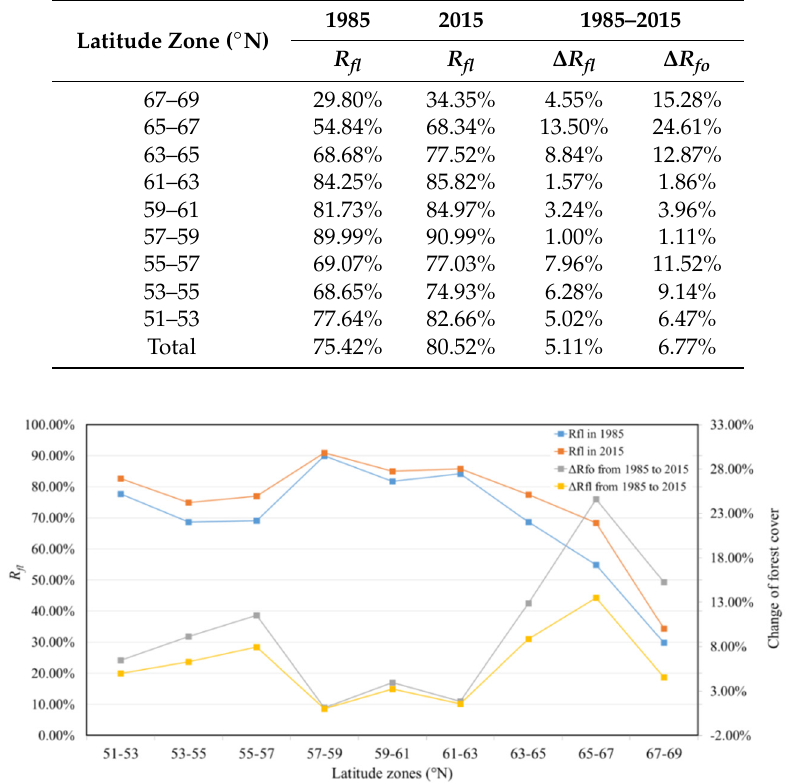
Table 3. Forest land area and ratio.